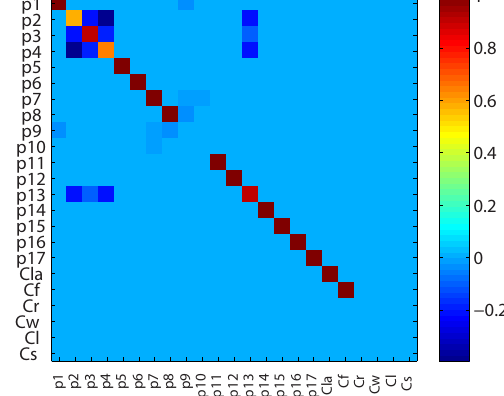
Figure 9. Model resolution matrix for LAI and static EDCs as de- fined by Eq. (52).